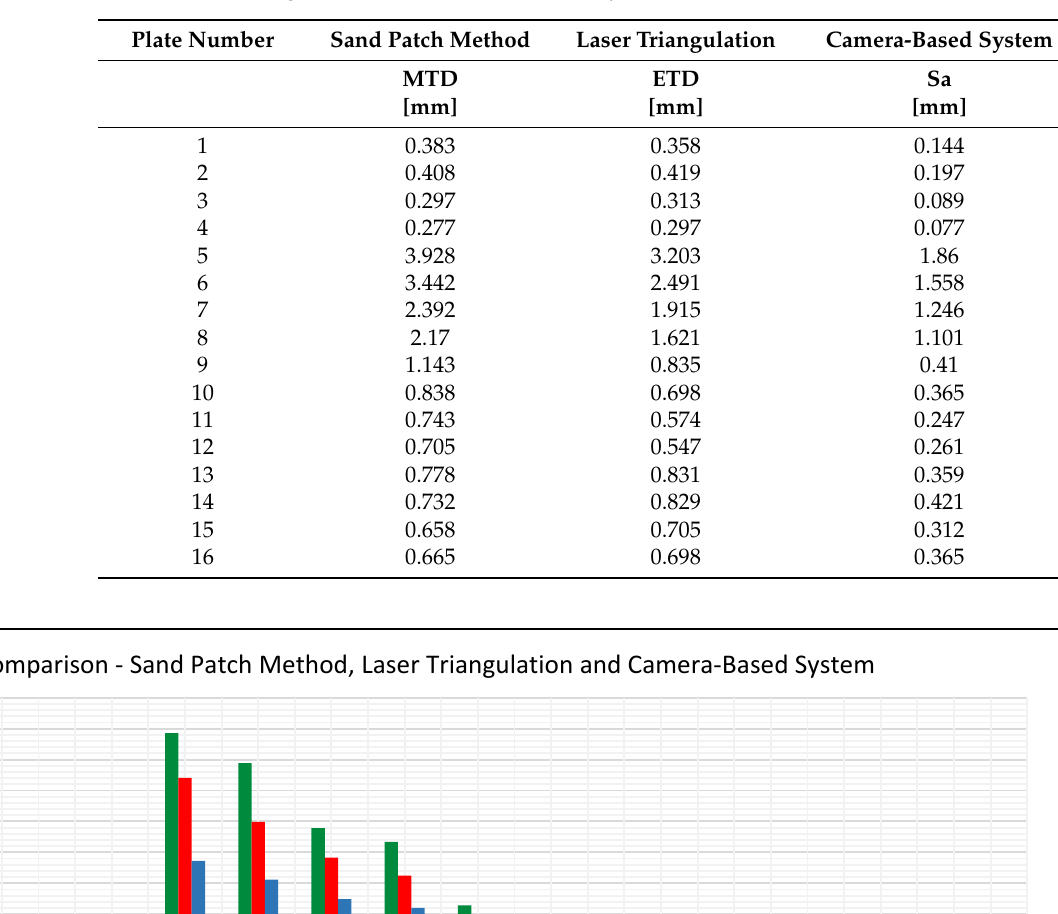
Table 5. Results of the roughness values for the 16 concrete specimens obtained using the sand patch method, laser triangulation and our camera-based system.